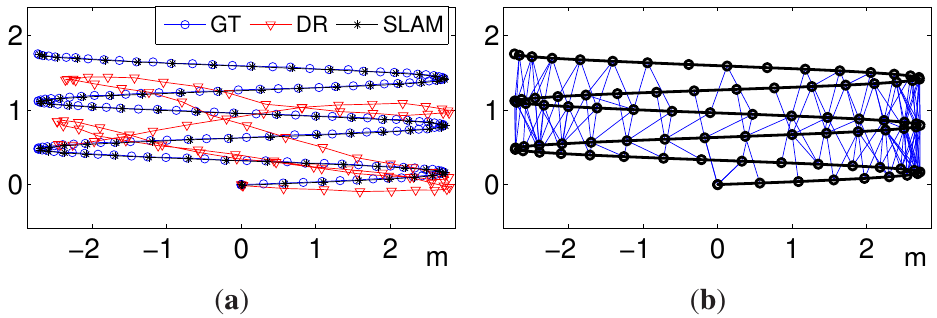
Figure 8. Example of the results obtained with Noise Level 2 and keyframe separation 10. GT and DR denote ground truth and dead reckoning. ( a ) Trajectories; ( b ) registered